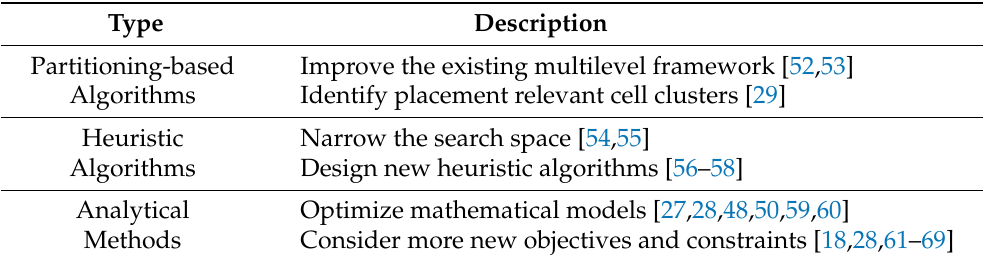
Table 2. Recent developments in classical placement